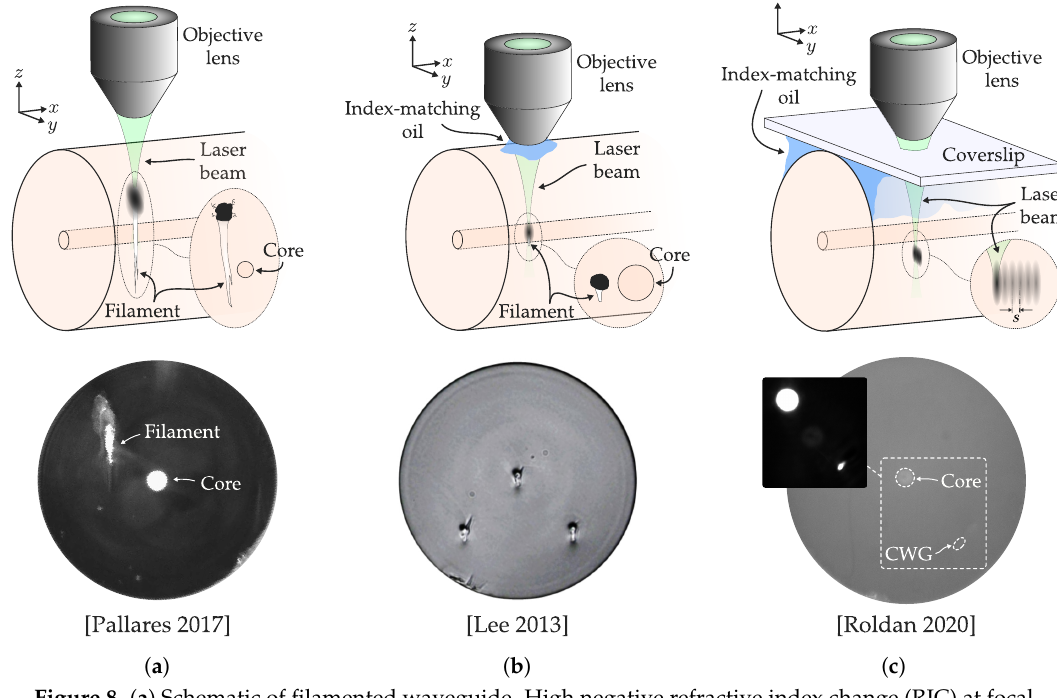
Figure 8. ( a ) Schematic of filamented waveguide. High negative refractive index change (RIC) at focal volume with guiding filament below (extracted from [118], ©IEEE). ( b ) Immersion oil microscope inscription. More controlled filament (adapted with permission from [121], ©The Optical Society). ( c ) Adaptive optics with multi scan technique. Smooth RIC, controlling width which each scan (extracted from [122],